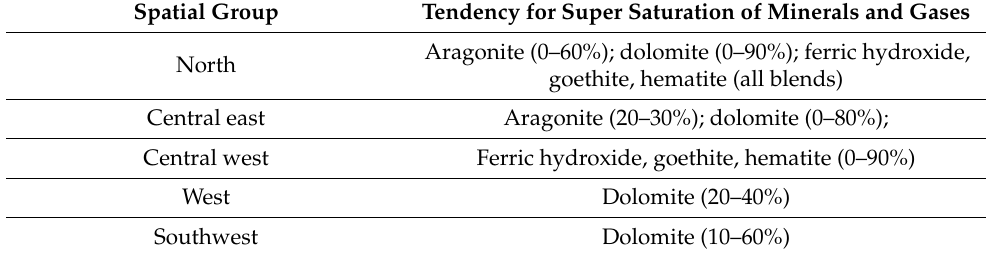
Table 7. Spatial group tendencies for mineral and gas precipitates for calcium-, CO 2 -, and iron- related products. Only high saturation index minerals are shown which are likely to precipitate. The percentage values show indicate the percentage of Ogallala water in each